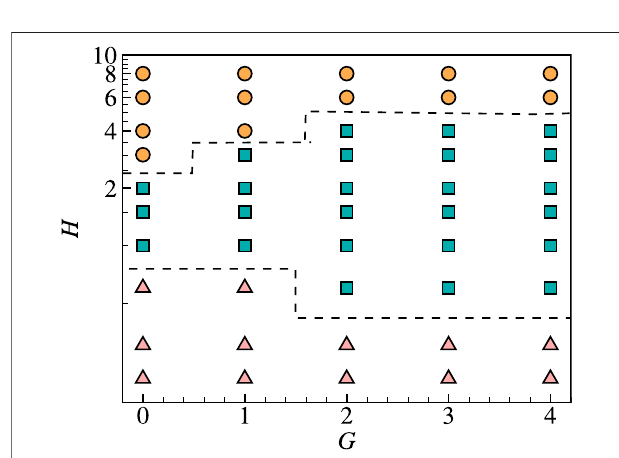
FIGURE 11 | Overview of the typical mode regions on the G - H plane for the three fl ags in right triangle con fi gurations. The symbols △ , □ and ○ denote the regular-coupled (RC), irregular-coupled (IC) and decoupled (DC) modes, respectively. The other governing parameters are as follows: Re =200, M =2.9, K =0.3 and S